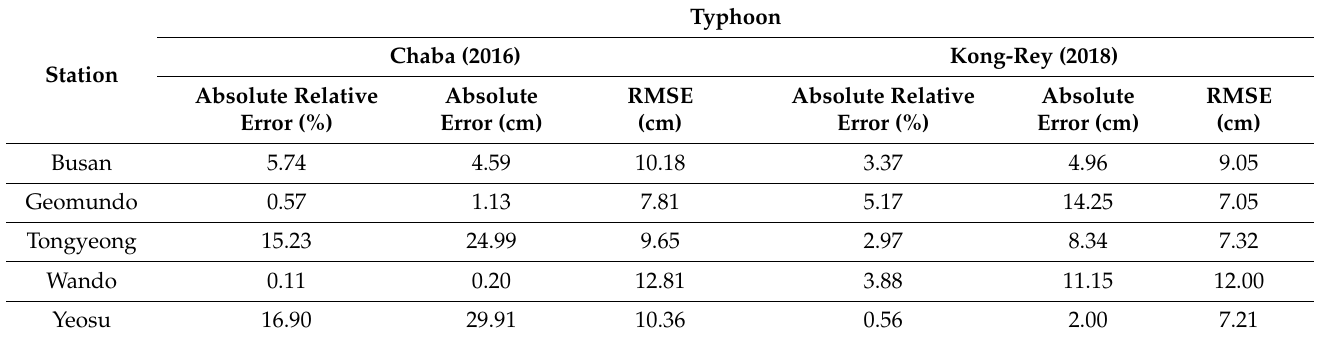
Table 4. Performance evaluation of the model. A relative error indicates the discrepancy between the observed and predicted tide levels, which is expressed as an absolute error. The absolute error is calculated using the observed and predicted tide levels at the maximum residual tide level. RMSE: root mean square error.